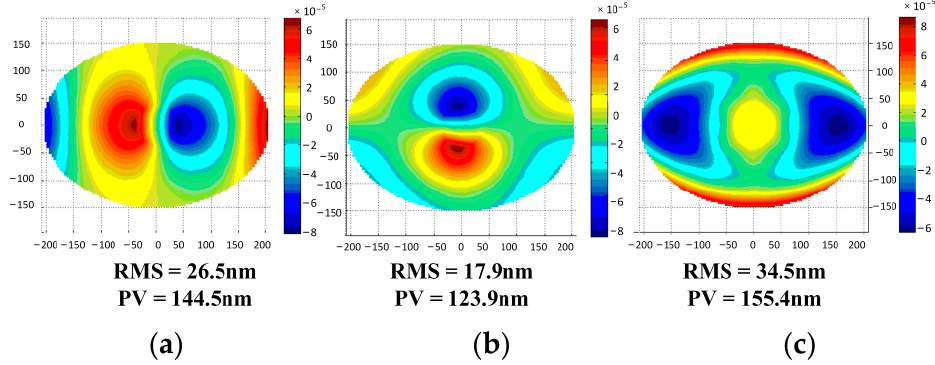
Figure 10. The fitting result of the mirror surface under 1 g gravity of the mirror: ( a ) radial direction (X) surface accuracy; ( b ) radial direction (Y) surface accuracy; ( c ) Axial direction (Z) surface accuracy.